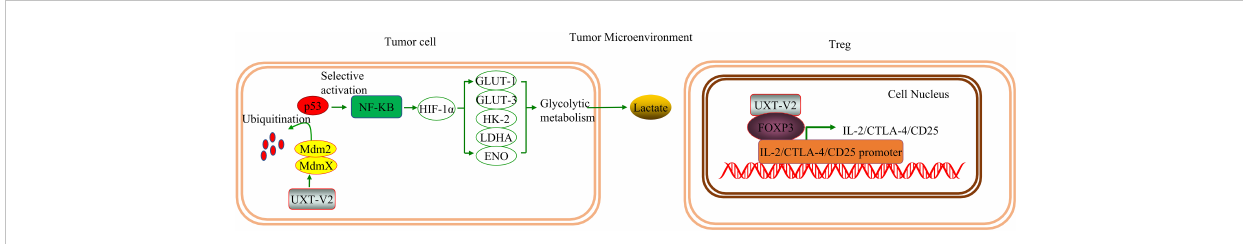
FIGURE 7 UXT regulates the tumor microenvironment: UXT-V2 promotes glycolysis by selectively activating the NF- k B signaling pathway by inhibiting the P53 signaling pathway. Glycolysis is promoted to increase lactate production and to acidify the TME. When UXT-V2 expression is up-regulated in Tregs, FOXP3 mRNA and protein levels are also up-regulated. UXT-V2 can also help maintain the inhibitory phenotype of Treg by binding to FoxP3 and stabilizing FOXP3 binding to IL-2/CTLA-4/CD25